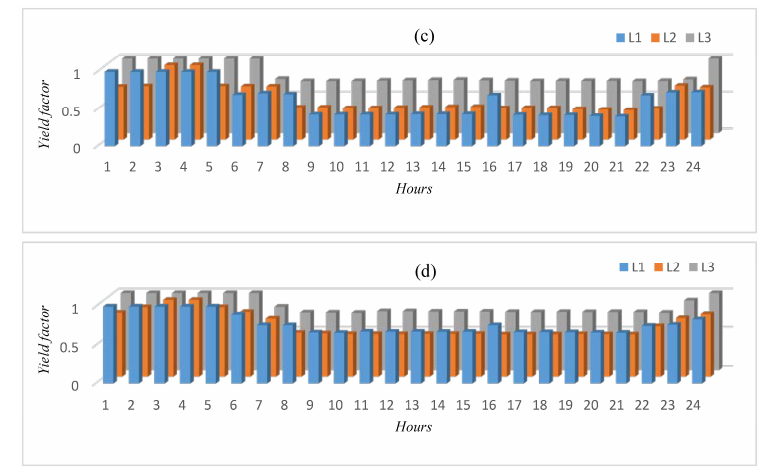
Figure 7. The yield factors for various locations of the MGs (L1, L2, and L3) in: ( a ) Area 1; ( b ) Area 2; ( c ) Area 3; and ( d ) the IEEE 30 bus system.